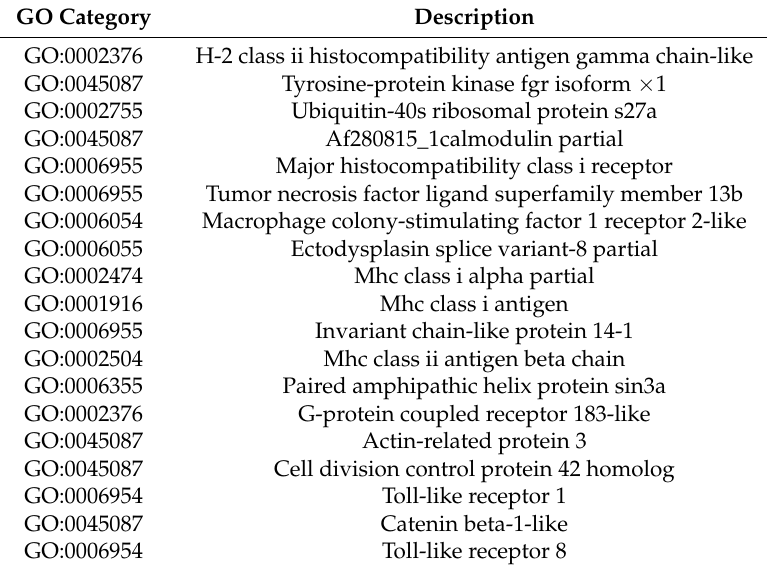
List of annotated Gene Ontology (GO) biological processes relevant to the innate and/or adaptive immune systems, detailing the number of corresponding annotated contigs in the Eleginops maclovinus